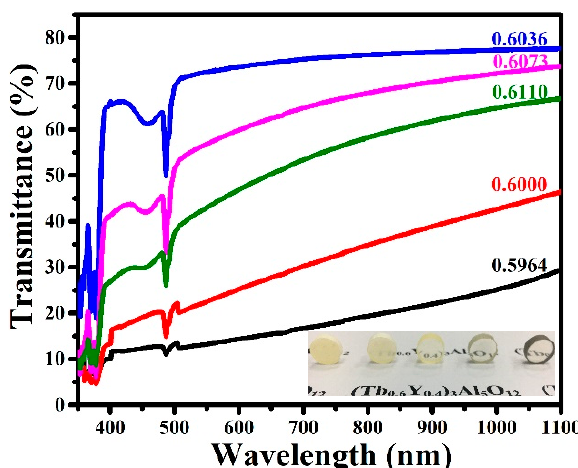
Figure 6. Transmittances of different (Tb+Y)/Al ratios pre-sintered at 1450 °C and with 1600 °C HIP treatment (4 mm thickness); Macroscopic observations of (Tb 0.6 Y 0.4 ) 3 Al 5 O 12 with different (Tb+Y)/Al ratios are displayed inside: from left to right (0.5964, 0.6000, 0.6036, 0.6073, and 0.6110).